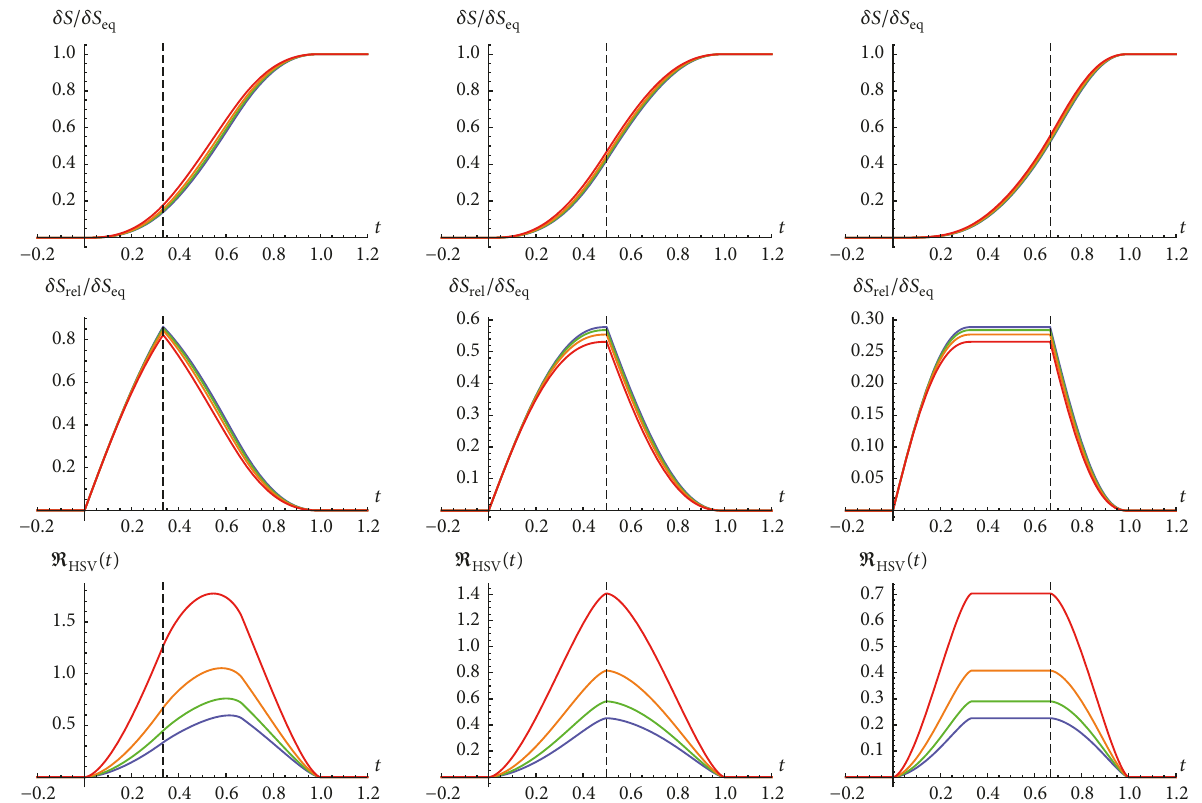
Figure 8: Entanglement entropy, relative entropy, and entanglement velocity for different dimensions. Colors blue, green, orange, and red represent 𝑑 = {5,4,3, 2} , respectively. Plots from left to right have 𝑡 𝑞 /𝑡 ∗ = {0.5, 1,2} . In all plots, the dashed vertical line denotes the end of the driven phase 𝑡 = 𝑡 𝑞 . We have set 𝑝 = 1 , 𝜃 = 0.1 , and 𝑧 = 1.5